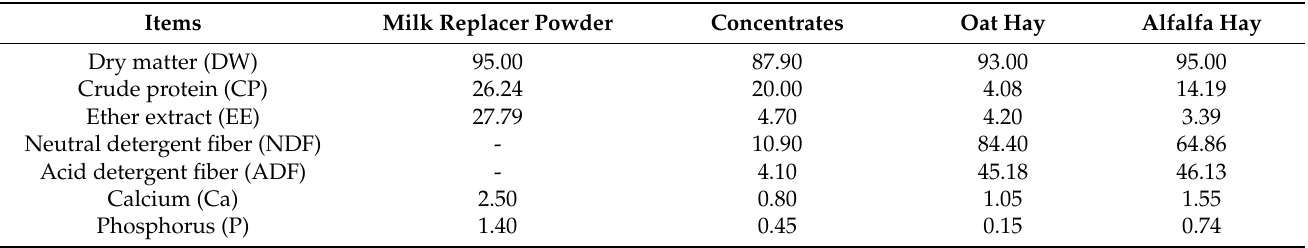
Table 1. Nutrient composition of milk replacer powder, concentrates, oat hay and alfalfa hay (dry matter basis) (Unit: